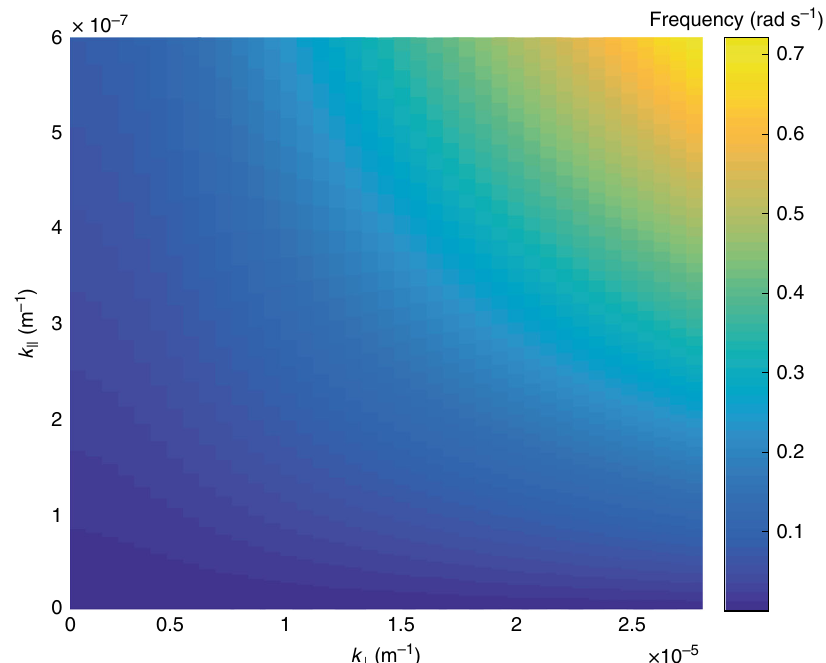
Fig. 8 Solution to the warm plasma dispersion relation. Frequency is shown as a function of parallel wavenumber as a function of perpendicular wavenumber and angular